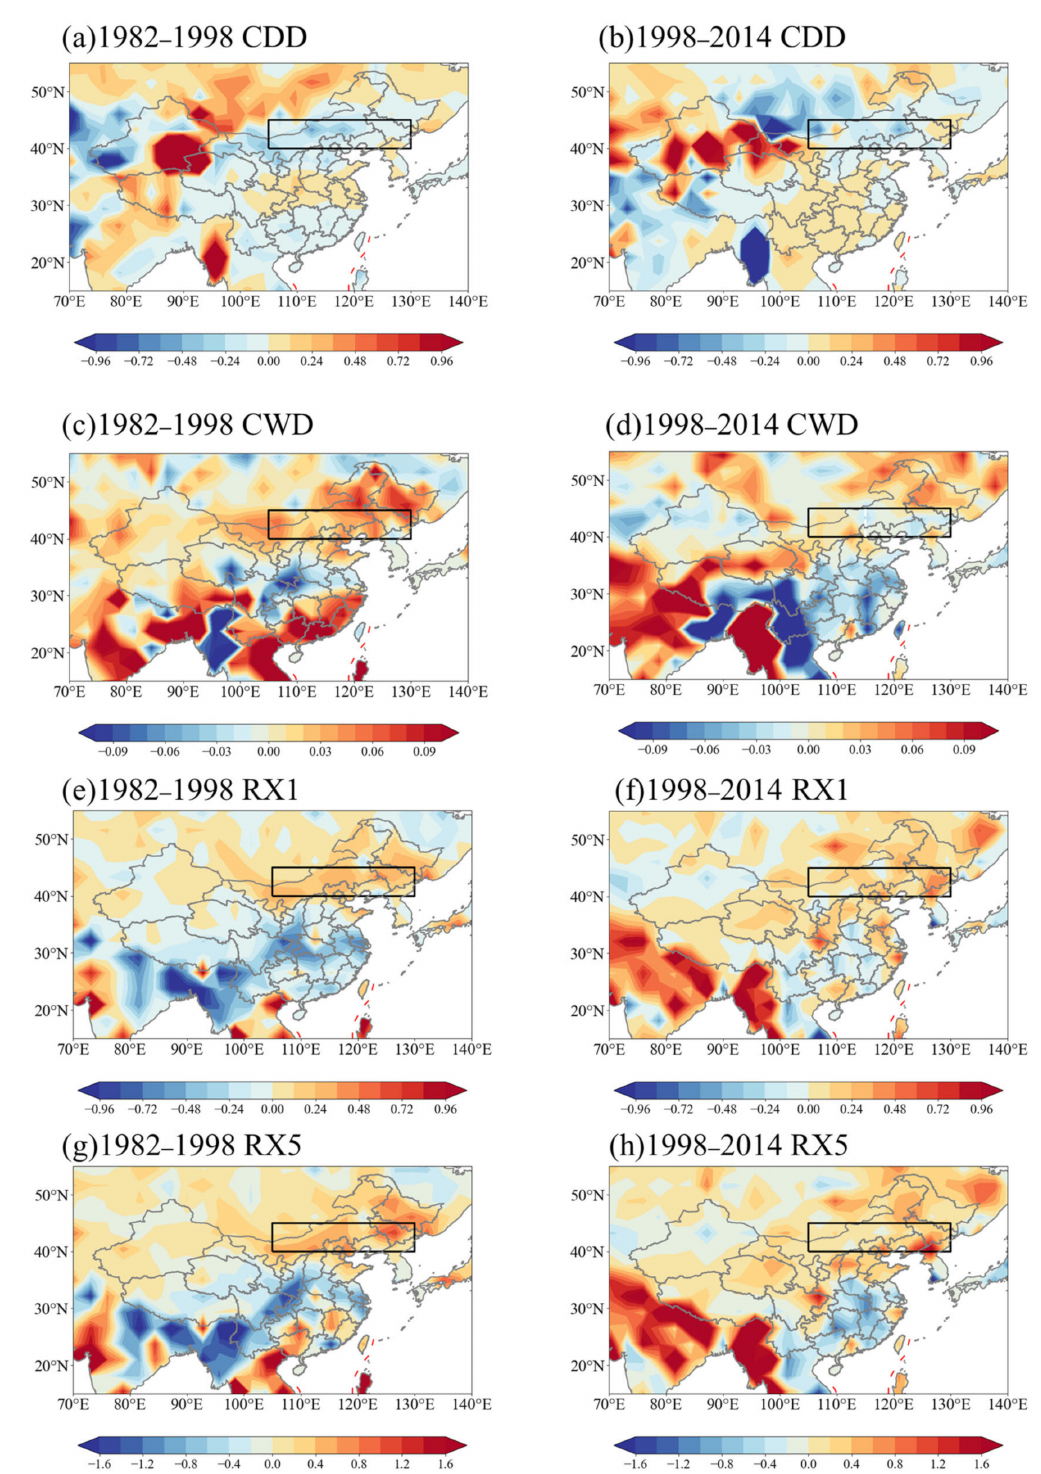
Figure 7. Trend analysis of four extreme indexes which are related to precipitation for different periods. ( a , b ) Consecutive dry days (days). ( c , d ) Consecutive wet days (days). ( e , f ) Maximum 1-day precipitation amount (mm). ( g , h ) Maximum 5-day precipitation amount (mm). Note: Warm tones represent an increasing trend, cool tones represent a decreasing trend. The red dashed lines in the figure represent Ten-dashed lines. The numbers below the description of the colors represent the trend slope value. The black box in it is defined as the northeastern region of East Asia (40~45 ◦ N, 105~130 ◦ E) and the white line in ( d ) represents the longitude of